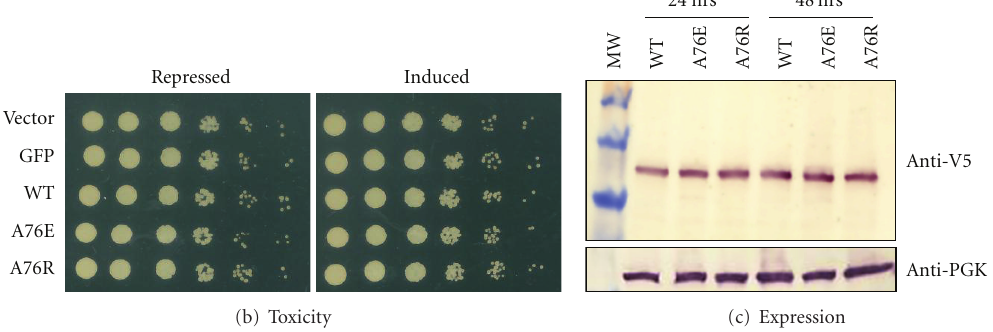
Figure 5: Characterization of alanine-76 in BY4741. (a) Live-cell GFP microscopy of BY4741 cells expressing WT, A76E, or A76R at 24 and 48 hours ( left ). Quantification: ∼ 750 cells of each type were scored for these localization patterns: cytoplasmically di ff use, and plasma membrane, aggregate, plasma membrane/di ff use, plasma membrane/aggregate ( right ). Phenotypes were plotted as a percent of total cells that fluoresced ( N = 2). (b) BY4741 cells expressing WT, A76E, or A76R were grown in inducing (galactose) media for 48 hours. Vector alone and GFP served as controls. Equal number of cells were serially diluted 5-fold and spotted onto repressing (glucose) or inducing (galactose) plates and grown for two days ( right ). No toxicity was apparent in budding yeast ( N = 3). (c) Western blot of BY4741 cells expressing WT, A76E, or A76R at 24 and 48 hours. Lysates were probed with anti-V5 ( α -synuclein) or anti-PGK. Expression is equivalent between WT and the alanine-76 mutants at 24 and 48